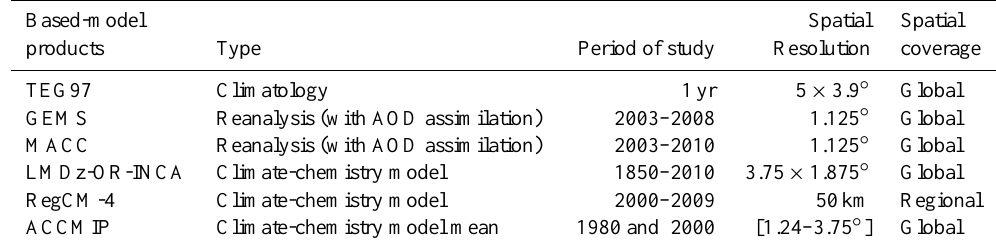
Table 2. Main characteristics of the different model-simulated products used in this